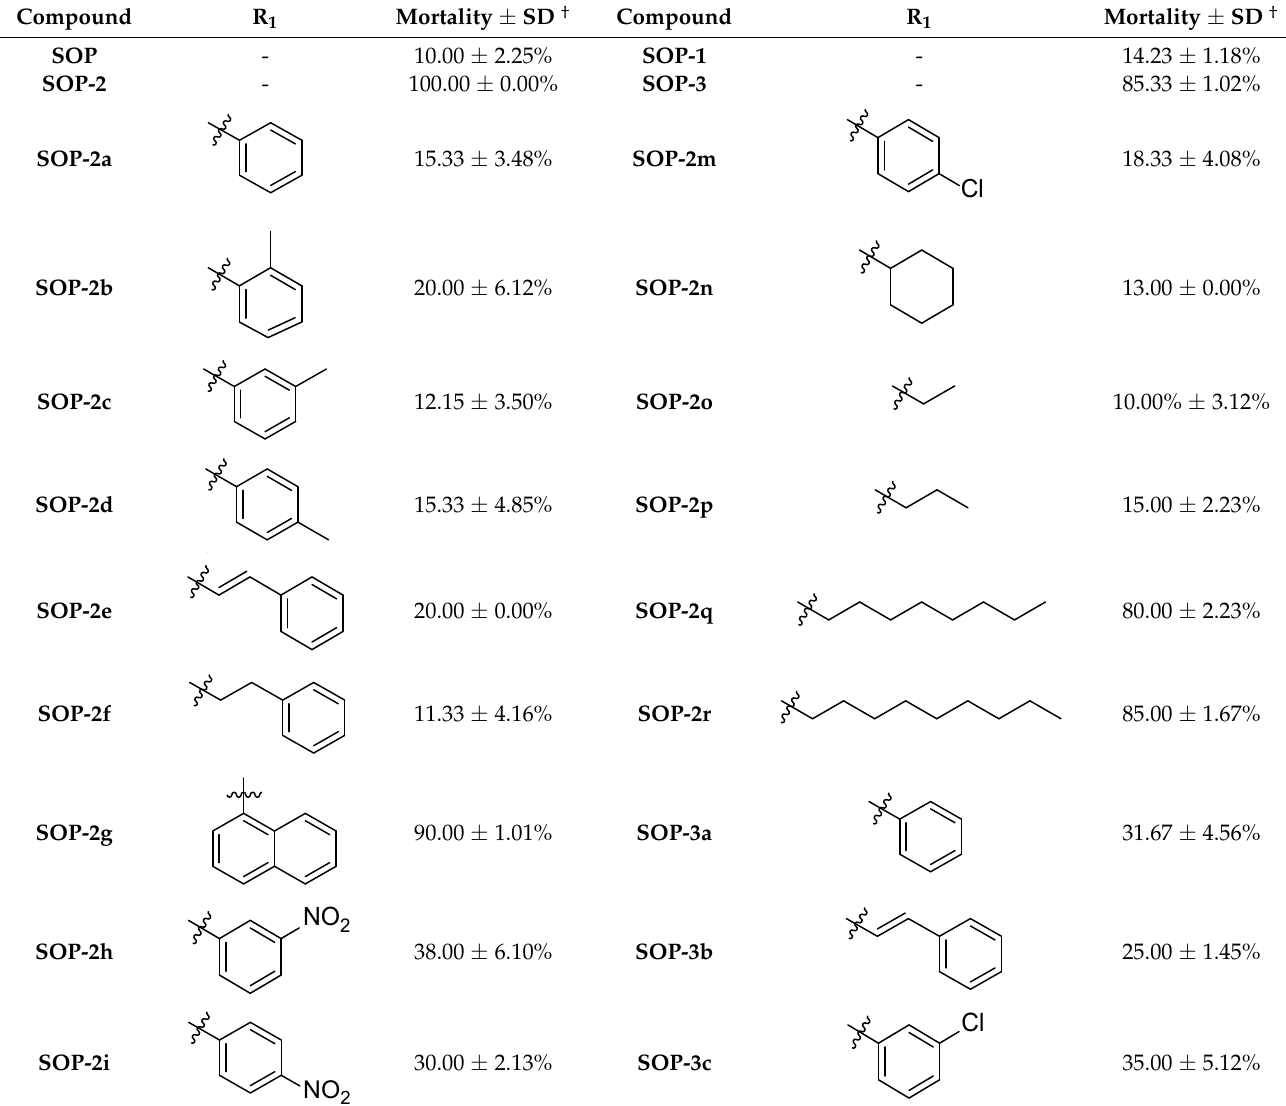
Table 1. Insecticidal activity against larvae of Ae. albopictus at 1000 ppm.